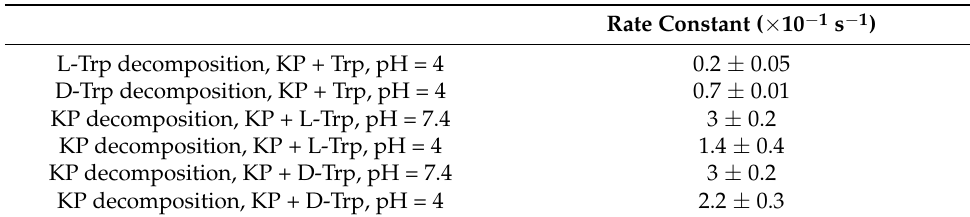
Figure 6. 1 H NMR spectra before and after irradiation (wavelength of the laser light is 308 nm) of 4 mM L/D-Trp in the presence of 2 mM S-KP in DHPC/DMPC bicelles in PBS at pH = 7.4 ( a ); at pH = 3.8 ( b ) showing the chemical shift of the singlet and decomposition of the Trp. Table 1. Rate constants of the decomposition of KP and L/D-Trp under irradiation in DHPC/ DMPC